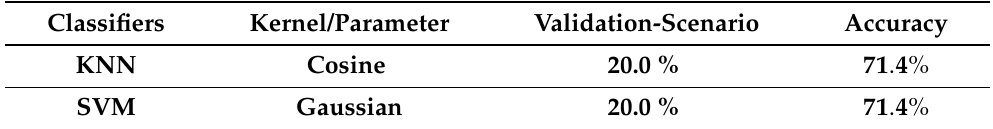
Table 13. The accuracy of classification of different classifiers of MAP-based experiment (108 subjects (balanced (54 normal, 54 hypertensive)).